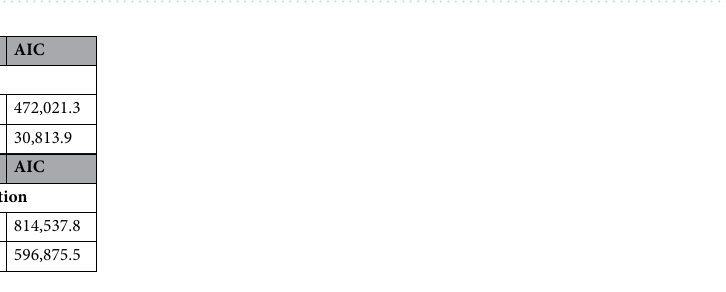
Table 2. Values of lag phase ( (cid:31) ), growth rate ( µ ), asymptote (A) and AIC when fitted to the modified Gompertz equation (Eq. 1), and lag phase ( (cid:31) ), growth rate ( µ ), c 0 and AIC when fitted to the Broken Stick equation (Eq. 2) for Klebsiella pneumoniae ATCC BAA-1705 and BAA-1706. The organisms were inoculated into Mueller Hinton cation adjusted broth and incubated at 37 °C in SLIC for up to 5